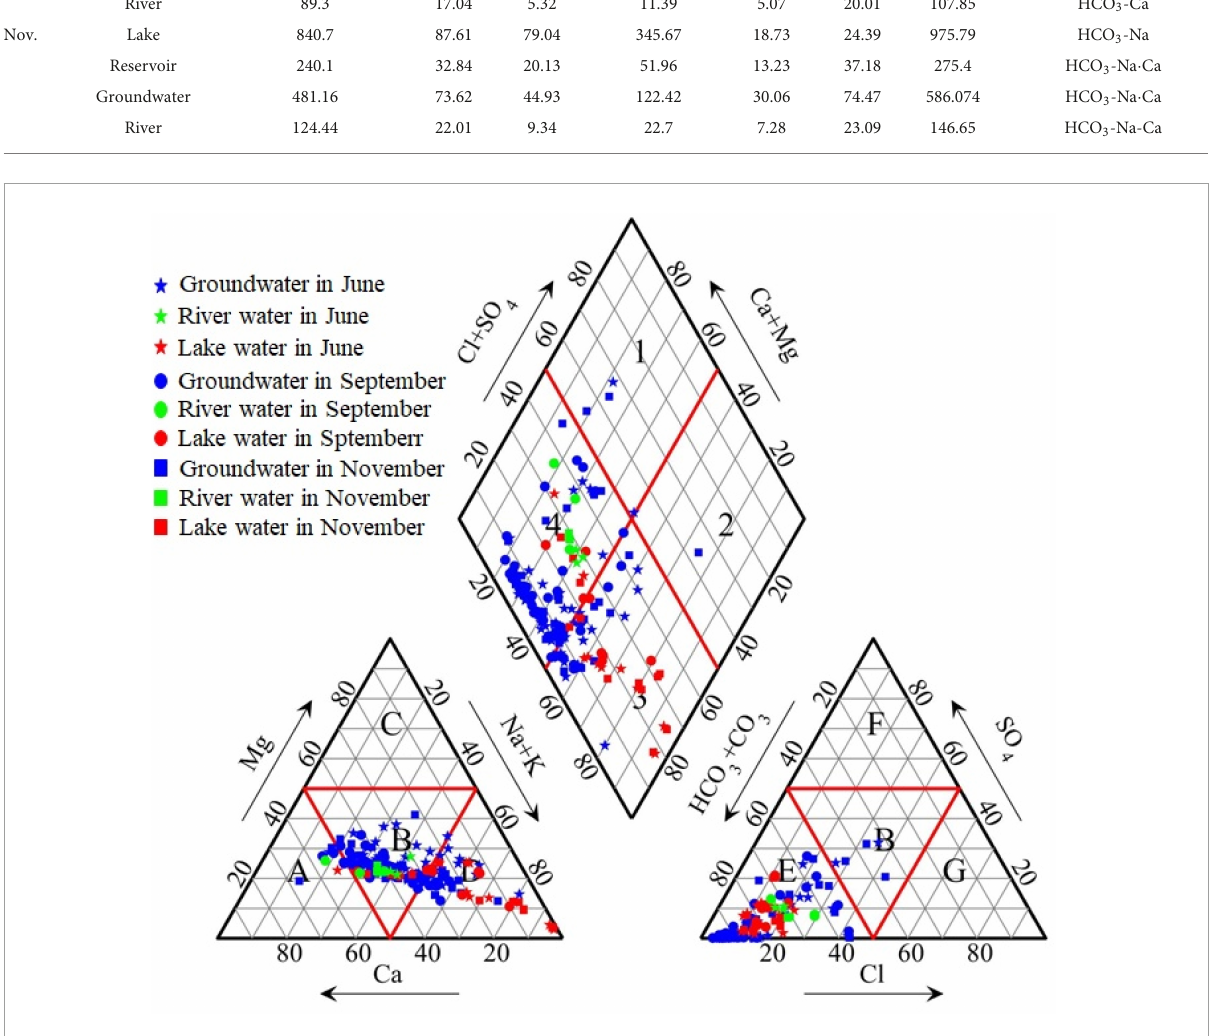
FIGURE2 Piper diagram of different water bodies in the study area.